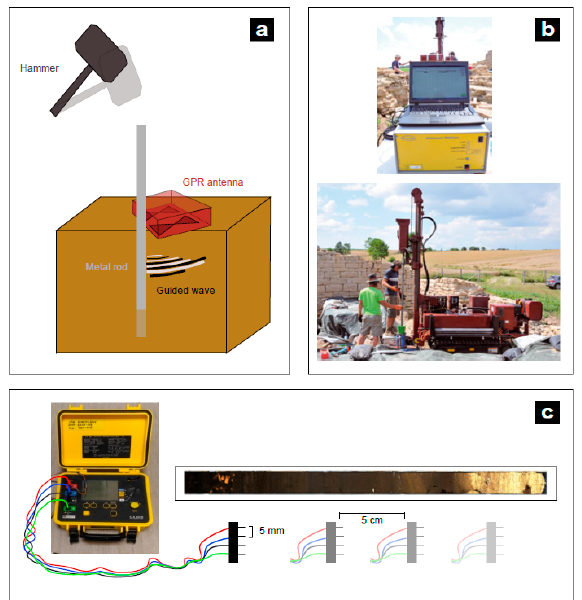
Figure 2. ( a ) Guided ground-penetrating radar (GPR) wave setup with a 400 MHz antenna on the ground surface and waveguide lowered by hammering; ( b ) Direct-Push (DP-EC) equipment; ( c ) laboratory measurements of the resistivity along the cores.